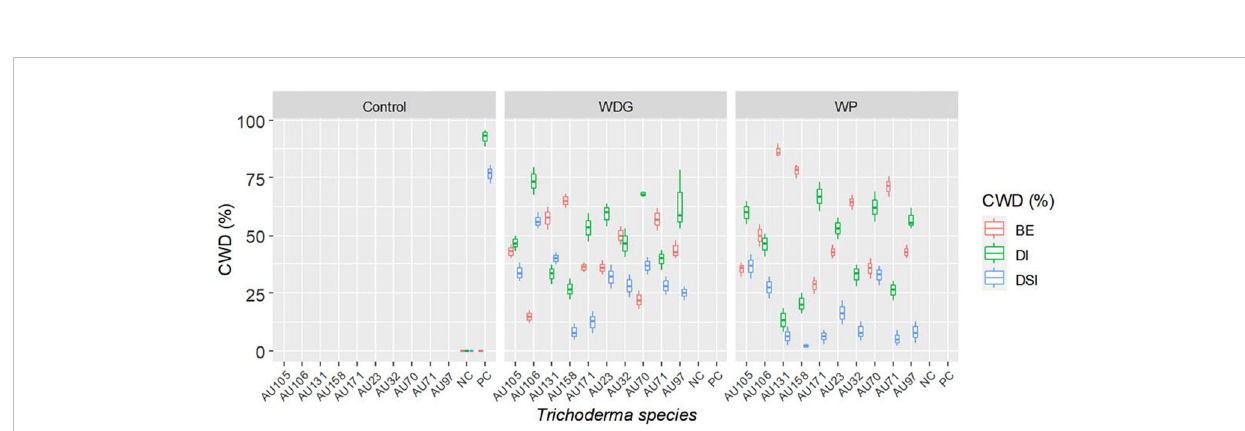
FIGURE 6 Boxplots of the antagonistic effectiveness of Trichoderma isolate WDG and WP products against F. xylarioides on coffee seedlings under greenhouse conditions. Trichoderma isolates: T. viride AU23, T. longibrachiatum AU32, T. koningiopsis AU70, T. asperelloides AU71, T. asperellum AU97, T. harzianum AU105, T. aethiopicum AU106, T. asperellum AU131, T. longibrachiatum AU158 and T. asperellum AU171. CWD, Coffee wilt disease; DI, Disease Incidence; DSI, Disease Severity Index; BE, Biocontrol Ef fi cacy; PC, Positive control; NC, Negative control; WP, Wettable Powder and WDG , Water Dispensable Granules. The boundaries of the boxplots indicate the 25 th and 75 th percentiles, and the solid line within the boxes indicates the median value.